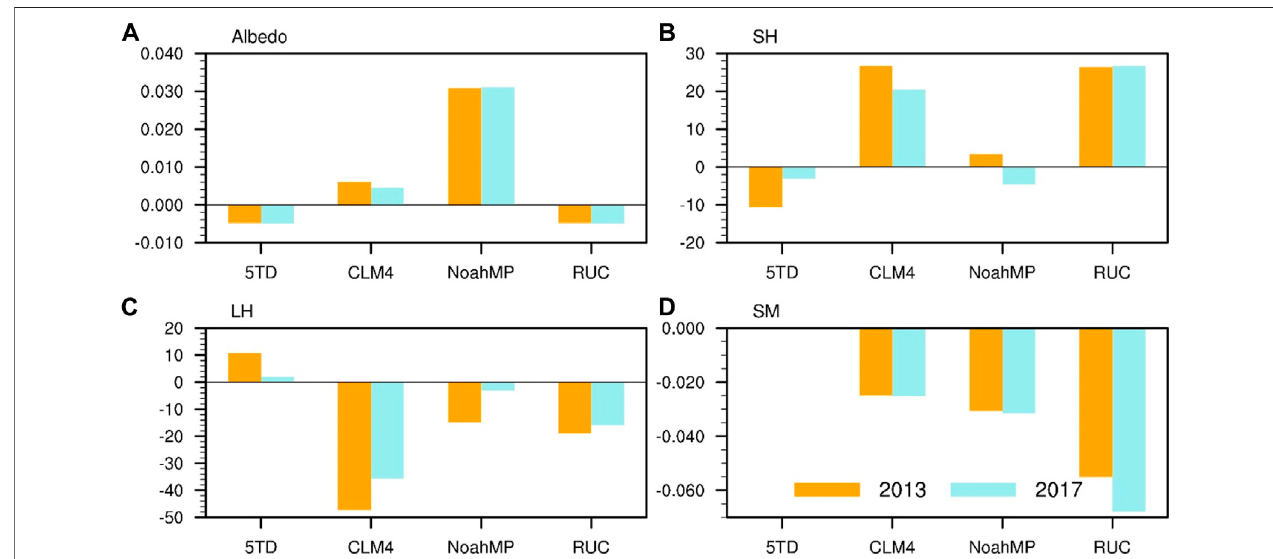
FIGURE9| ThearealmeandifferencesbetweenNoahandotherfourLSSsin (A) albedo, (B) SH, (C) LHand (D) soilmoistureoverthestudyregion(outlinedboxes in Figure 2A ) for the summer of 2013 (yellow) and 2017 (blue).